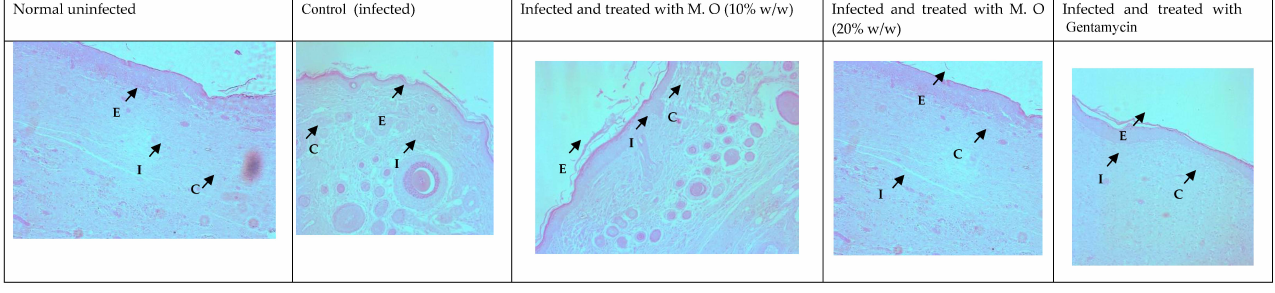
Figure 12. Skin histology of P. aeruginosa -infected wound (stained with H & E) after different treatments showing epidermis (E), capillaries (C), and inflammatory cells (I).